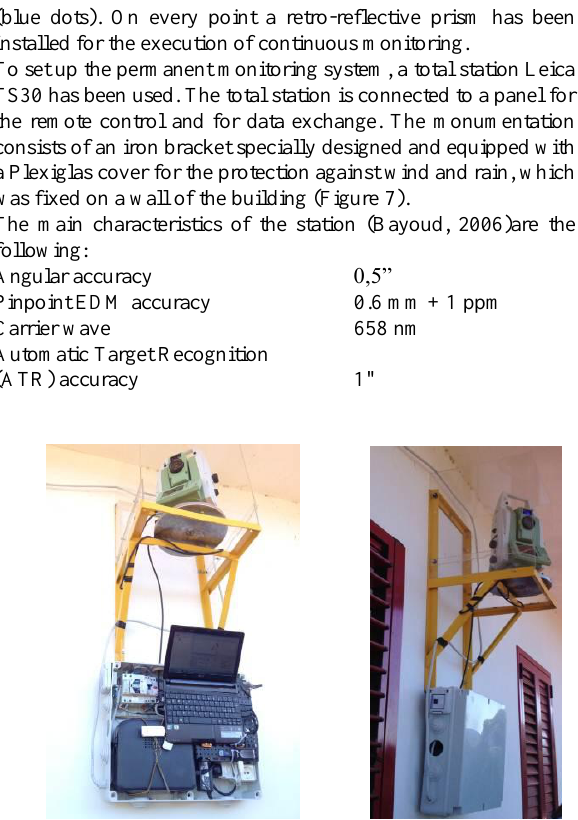
Figure 7. The total station and the control panel